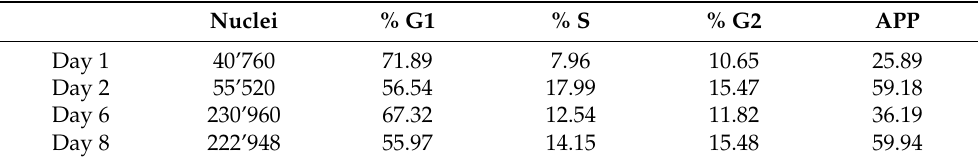
Table 3. Analysis of the nuclei by flow cytometry. The nuclei can be divided into three groups based on different DNA amount. The three phases of interest, G1, G2, and S, are distinguishable (see Supplementary Material Figures S8 and S9). The data are shown for the four measurements (day 1, 3, 6, and 8). The table shows the number and percentages of nuclei found in G1, G2, or S phase for ASC52telo grown on BR44 . The active proliferation percentage (APP) was calculated as follows: APP = ((G2 + S)/G1) ×